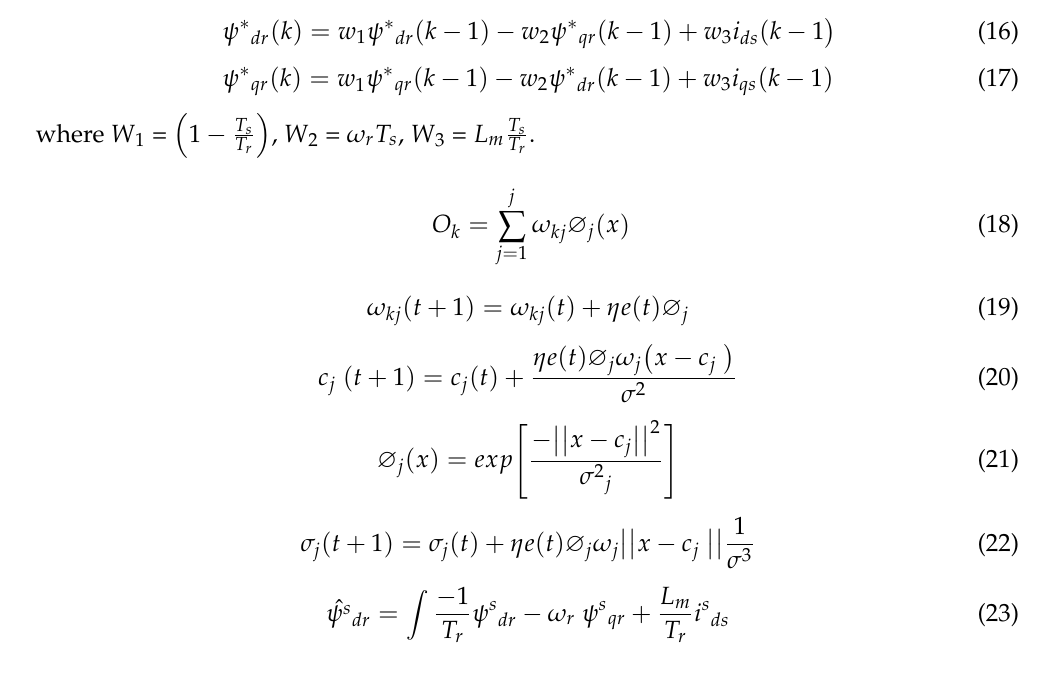
Figure 5. Neural network ‐ based adaptive model.